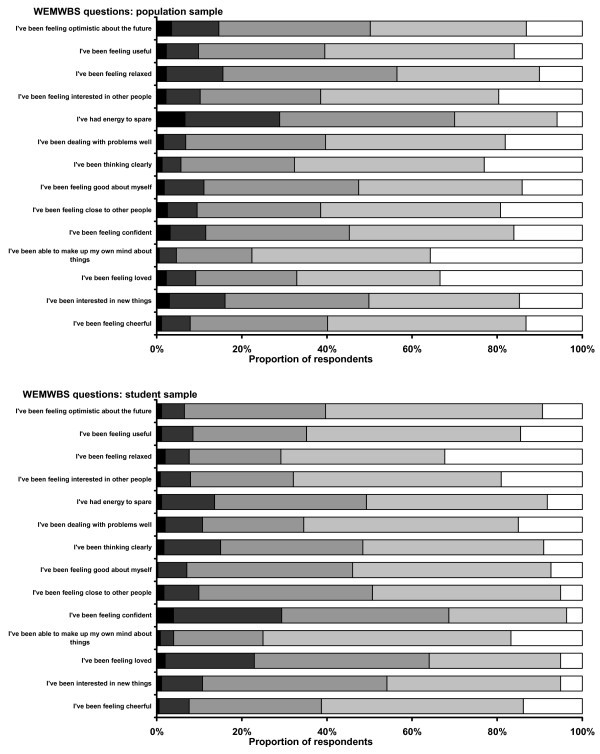
WEMBS question responses: student and population samples.